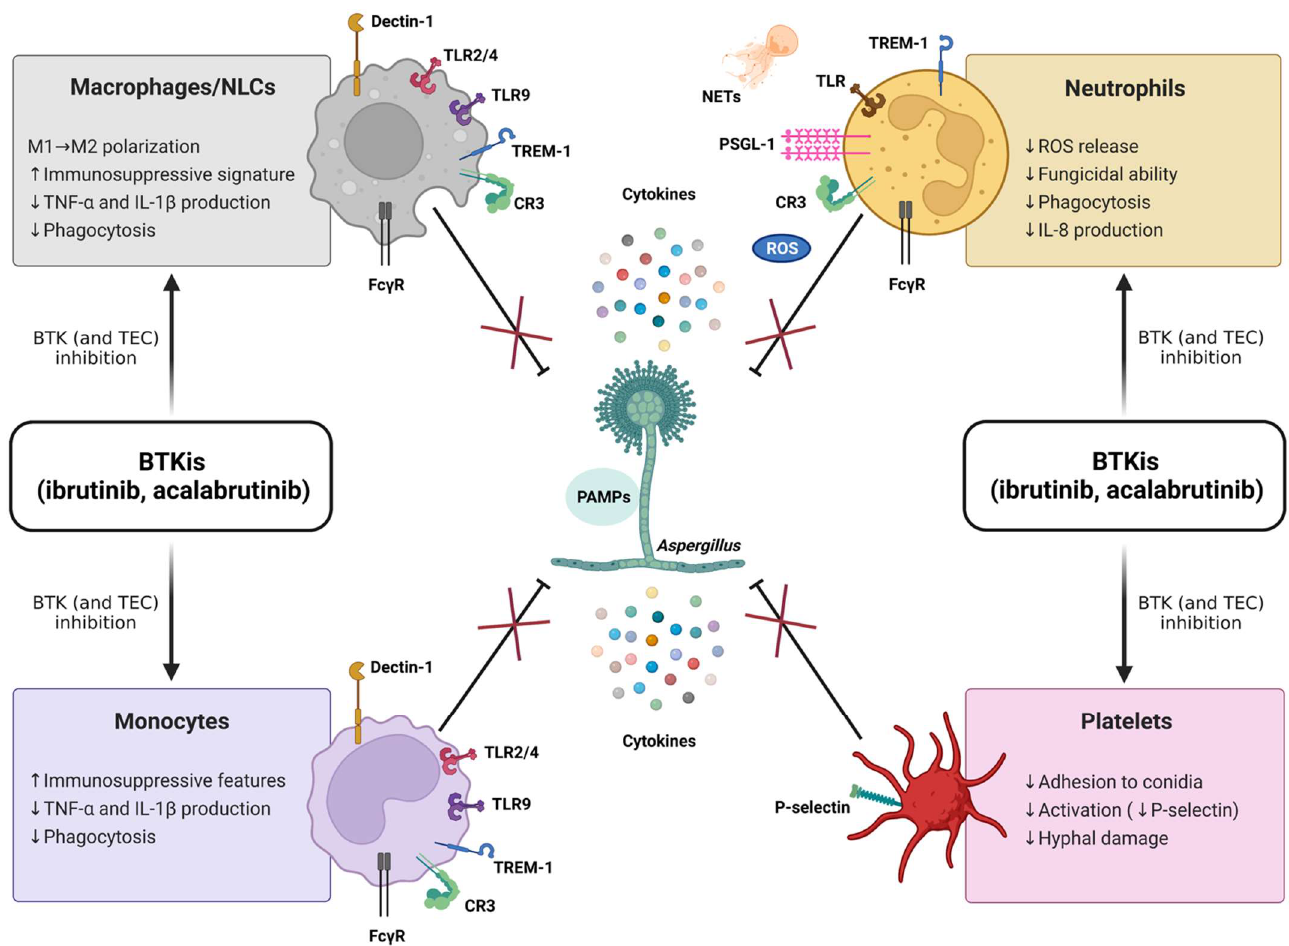
Figure 6. BTK inhibitors (BTKis) suppress (×) antifungal immune responses (  ) mediated